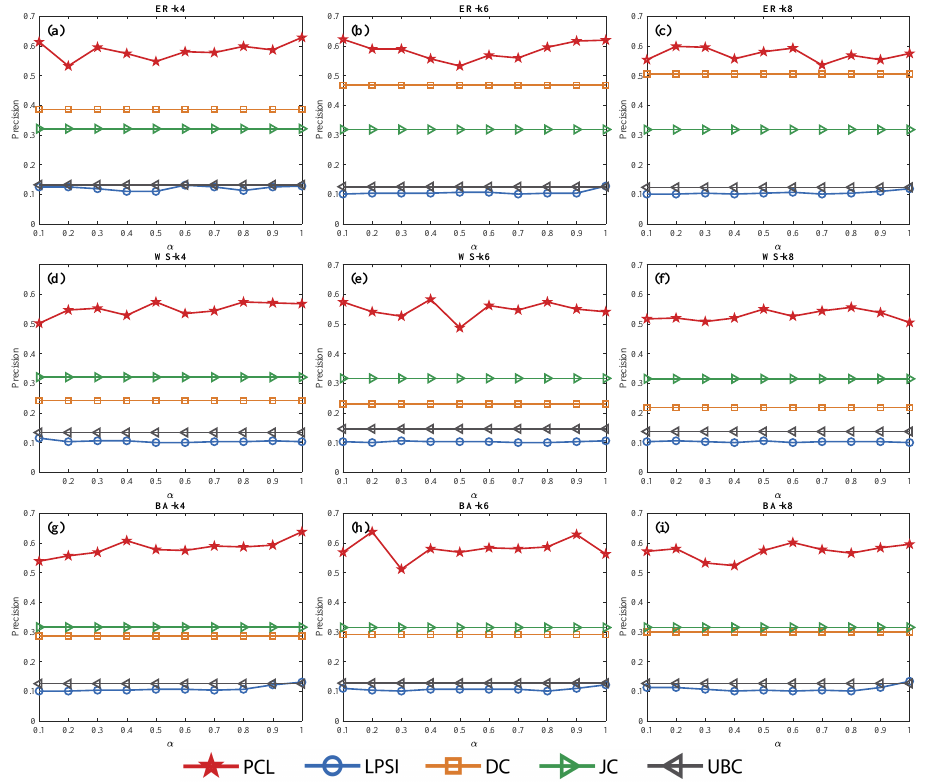
Figure 6. Sources localization accuracy of different average degree with five methods in synthetic networks. ( a – c ) Results in ER network. The average degree is < k > = 4,6, 8 respectively, the scale of network is N = 100. The number of sources is s = 3, the same as Figure 7. ( d – f ) Results in WS network. ( g – i ) Results in BA